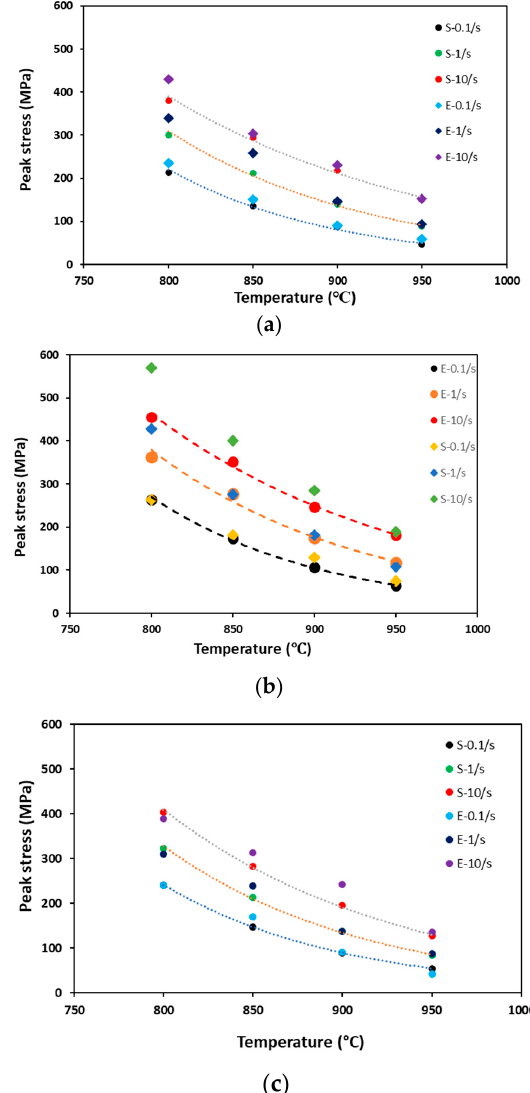
Figure 2. Peak stress obtained from the experiment and DEFORM-3D simulation ( a ) Ti-4.5Al-1V-3Fe; ( b ) Ti-6Al-1V-3Fe; and ( c ) Ti-6Al-4V. * S represents simulated peak stress, and E represents experimental peak stress.